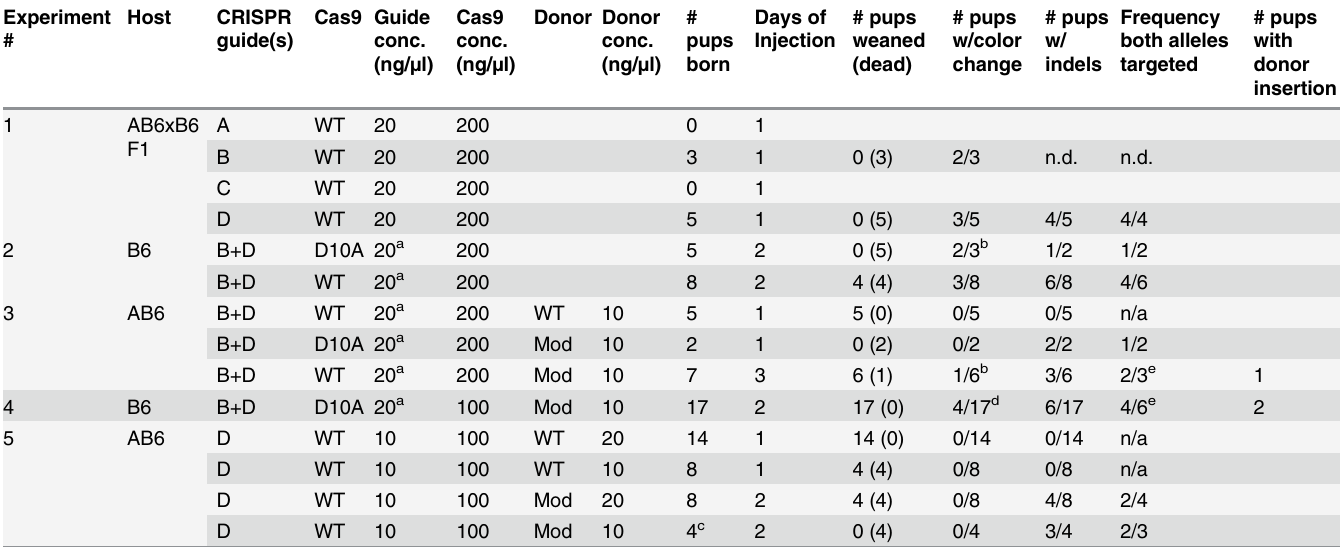
Table 1. Tyrosinase genome editing experiments via CRISPR-Cas9. Experiment #